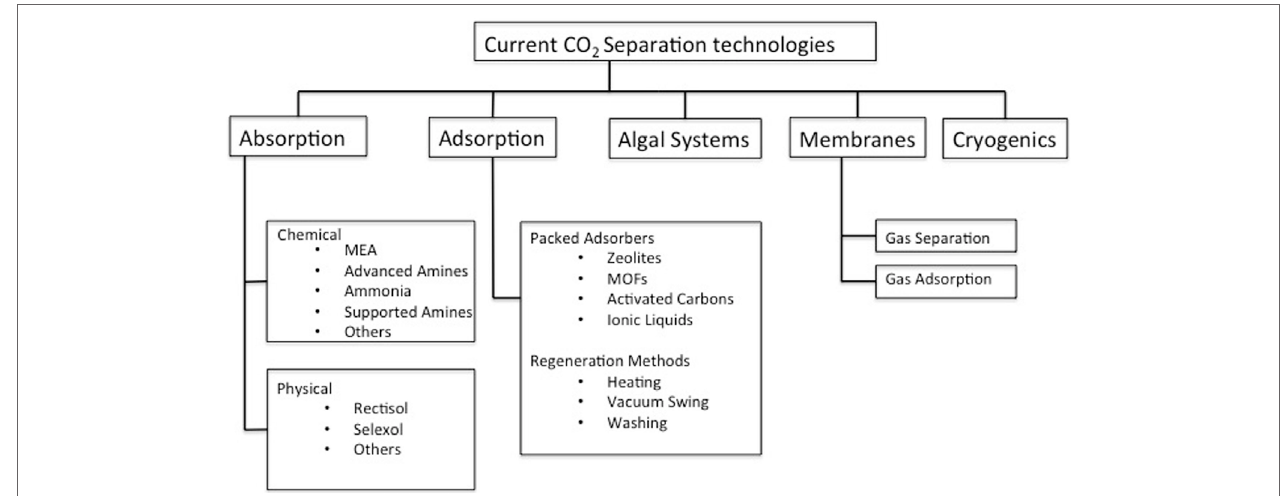
FigUre 1 | Current leading CO 2 separation